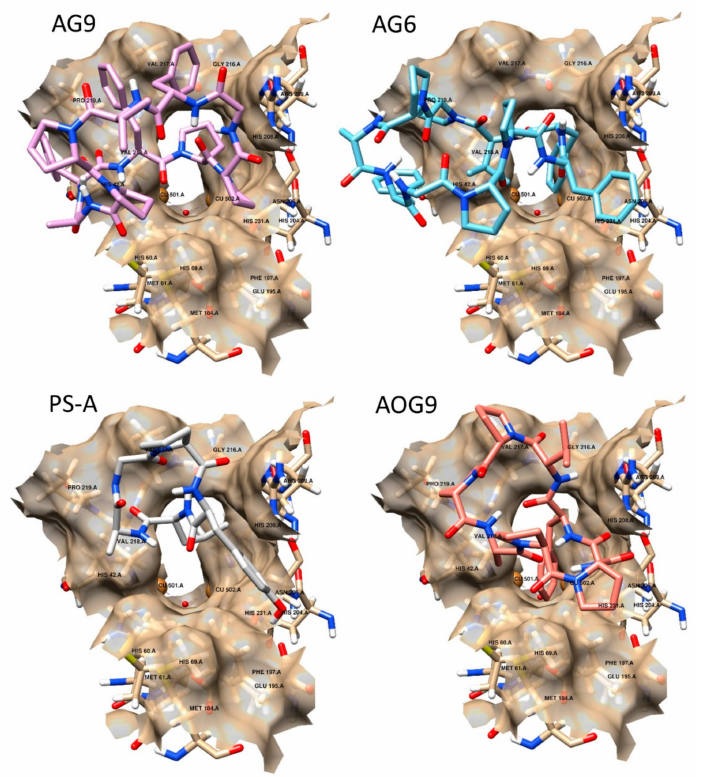
Figure 7. Docking simulation of cyclopeptides with B. megaterium tyrosinase protein (PDB file: 3NM8) evidencing the representative amino acids residues of the catalytic site, AG6 (light blue), AG9 (pink sticks), AOG9 (light red sticks) and PS-A (grey